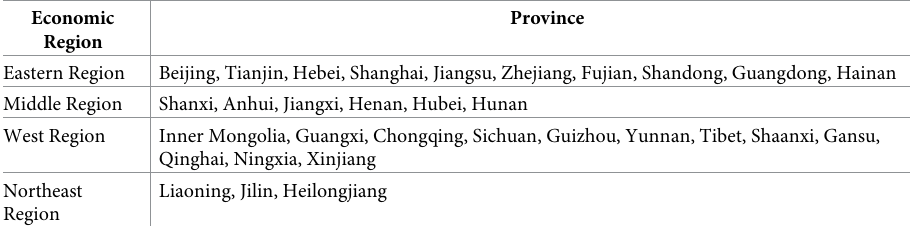
Table 14. Classification of China’s four major economic regions.